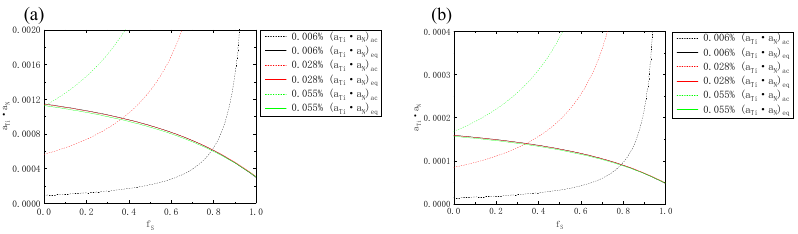
Figure 18. Relationship between TiN activity product and solid fraction of steel with different Ti content ( a ) liquid phase; ( b ) solid phase.